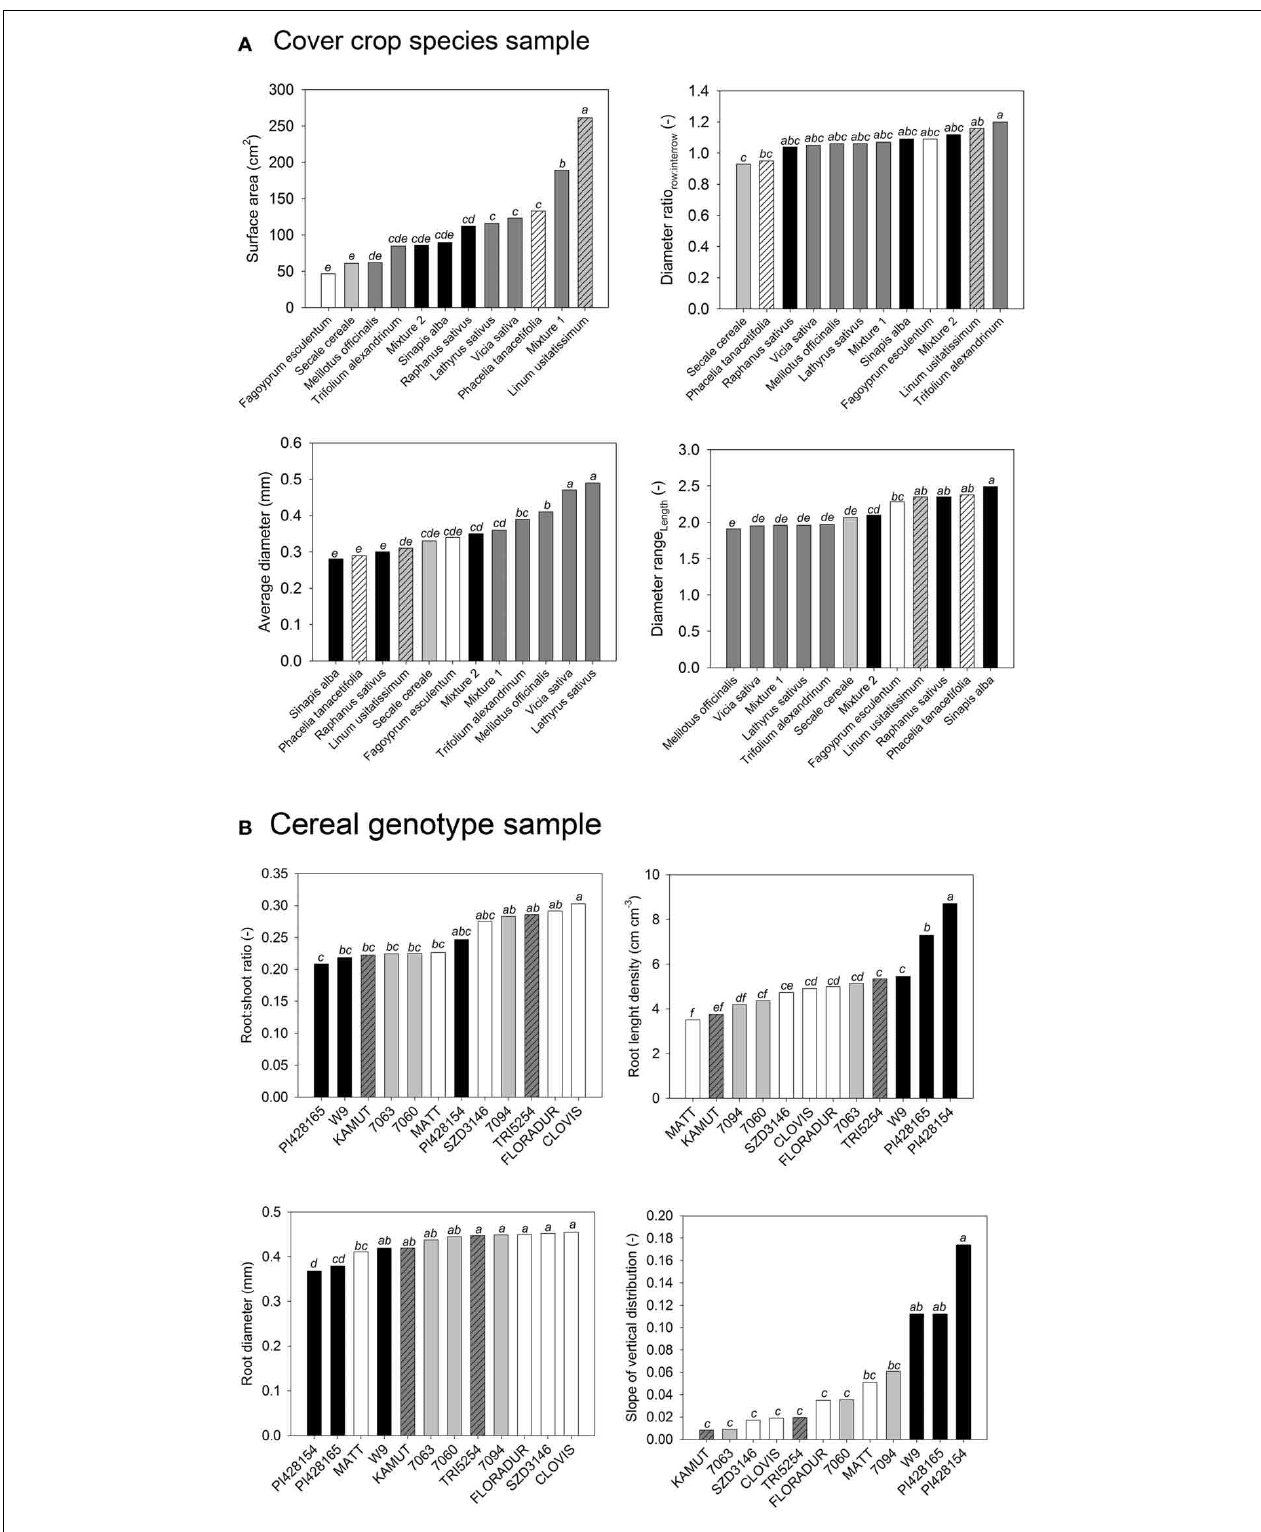
FIGURE 2 | Analysis of variance of selected root morphological traits from (A) the cover crop and (B) the cereal genotype sample. Change in neighboring bars of species order shows that single trait analysis leads to